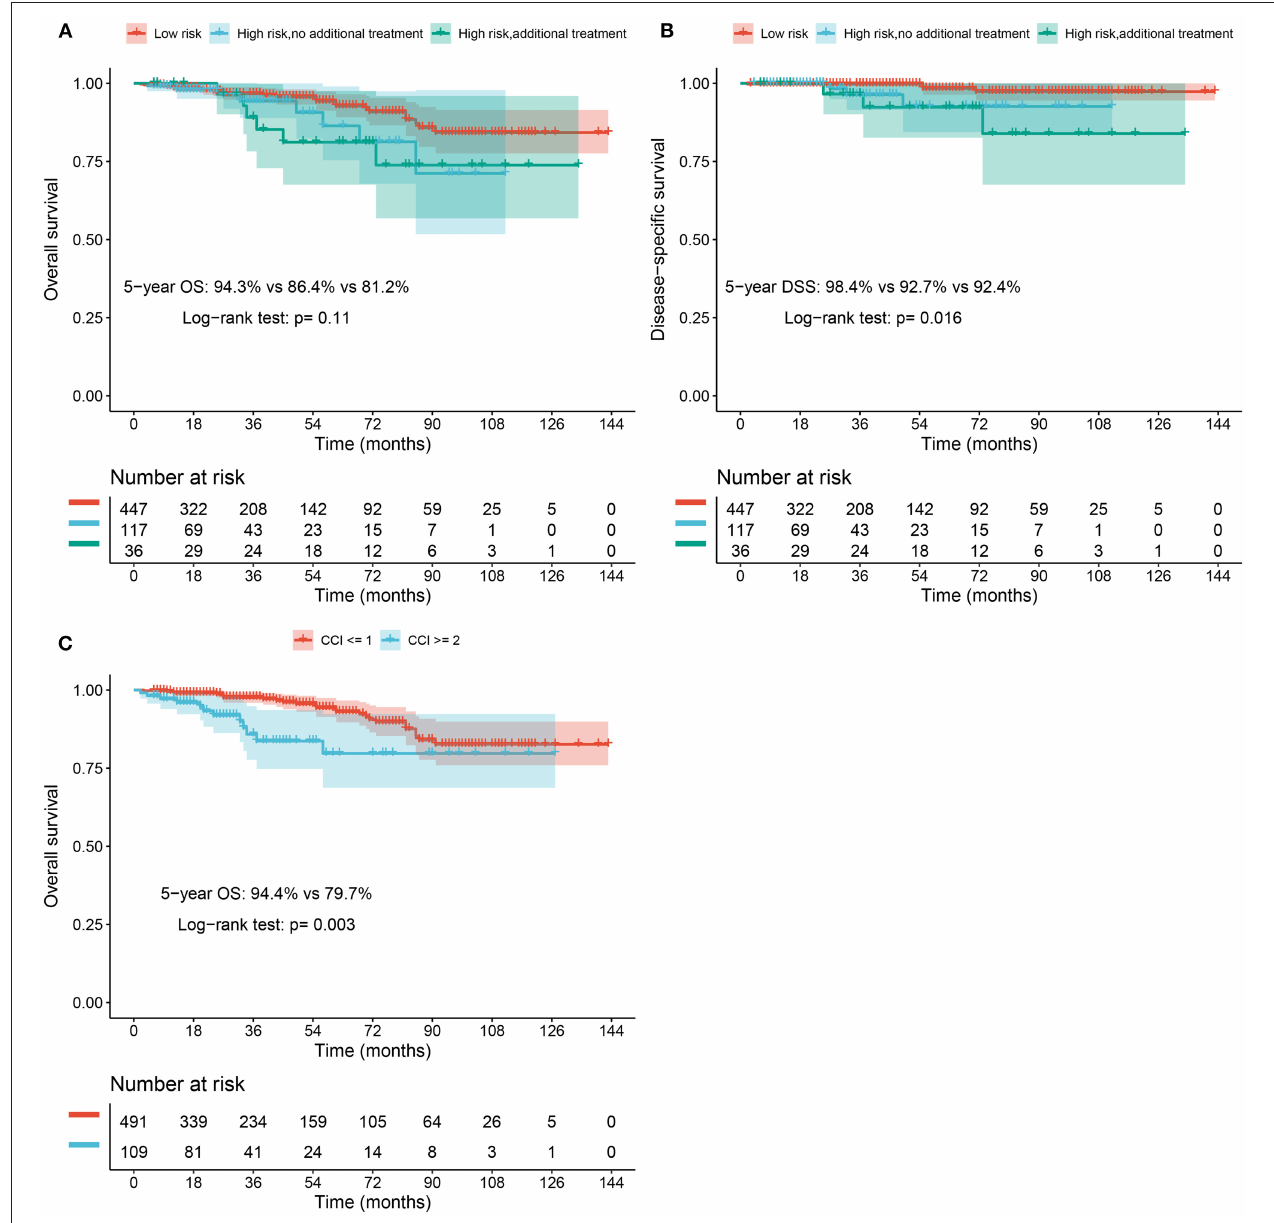
FIGURE 1 | (A) Overall survival rate of elderly patients with EGAC after ESD stratified based on the risk of LNM. (B) Disease-specific survival rate of elderly patients with EGAC after ESD stratified based on the risk of LNM. (C) Overall survival rate of elderly patients with EGAC after ESD in CCI ≥ 2 and CCI ≤ 1 groups.